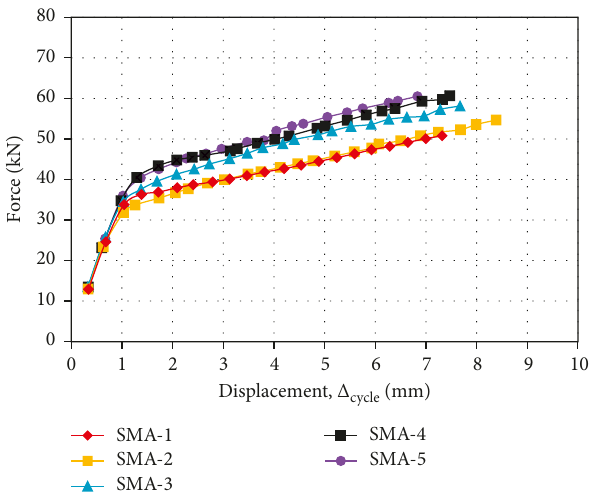
Figure 19: Comparison for residual displacements along the measurement displacement loading cycles (SMA material model